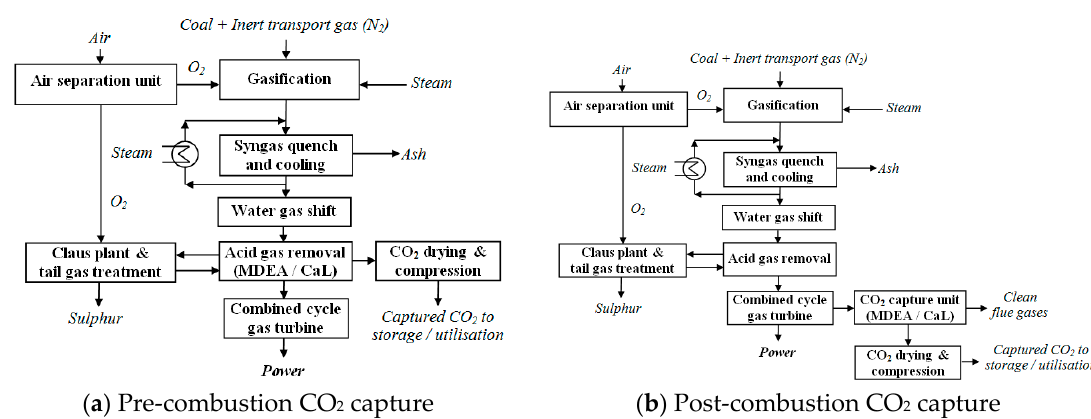
Figure 3. Decarbonized Integrated Gasification Combined Cycle (IGCC) power plant options.